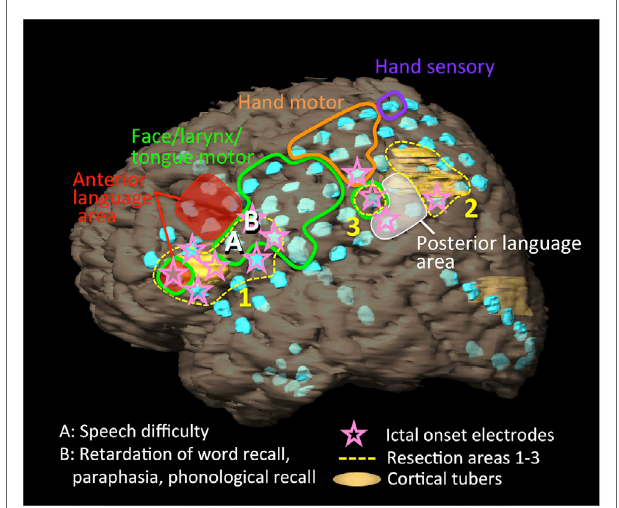
FIgURe 2 | Schema of the patient’s left hemisphere, cortical tubers (yellow regions), intracranial electrodes (light blue disks), results of extraoperative functional mapping of anterior language area (red shaded), posterior language area (white shaded), motor area of face/larynx/tongue (green loop), hand (orange loop), and hand sensory area (purple loop), ictal onset electrodes (pink stars), and resection areas (yellow dot loops: 1–3). We implanted 92 electrodes [2 grid electrodes (8 × 5, 4 × 5), 3 strip electrodes (10, 8, 8), and 1 depth electrode (6)]. One cortical tuber was present below and over the anterior language area. Another cortical tuber distributed posterior to the posterior language area. Ictal onset electrodes partially overlapped with the anterior and posterior language areas. The resections were performed from the resection areas of 1, 2, to 3. During the resection surgery, the patient presented with speech difficulty after the resection of site A, and retardation in responsive naming, paraphasia, and phonological recall after the resection of site B.